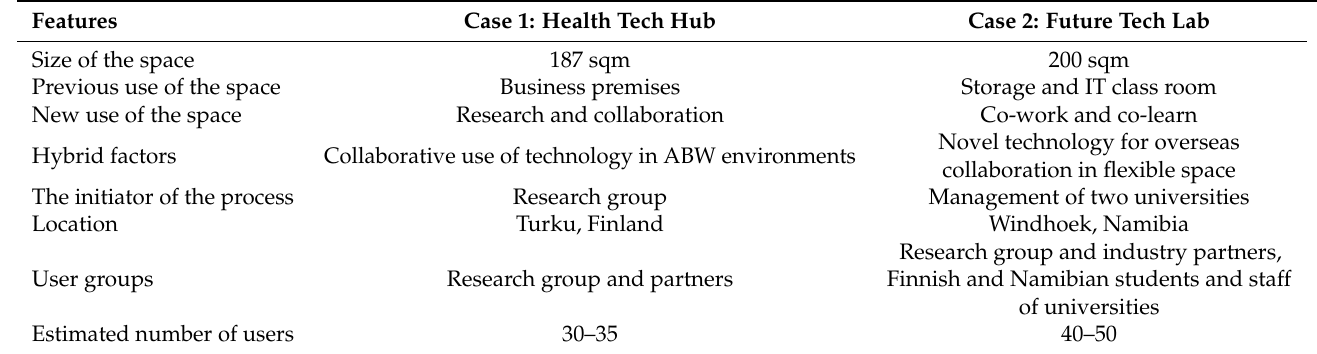
Table 2. Summary of the